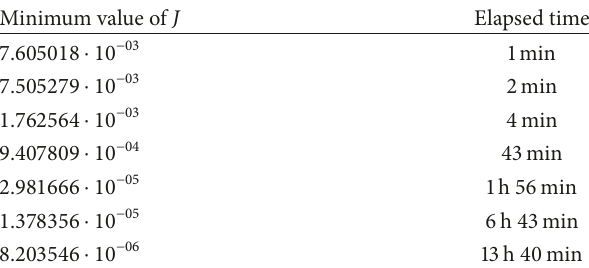
Table 4: Results on the hybrid